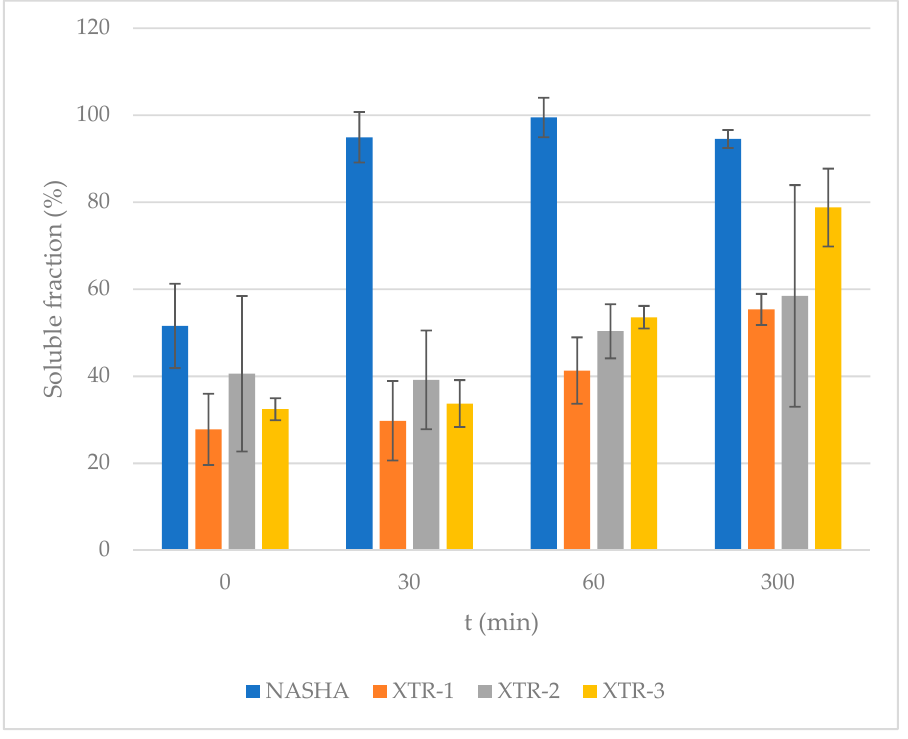
Figure 5. Percentage of soluble fraction for each gel type (mean and standard deviation).